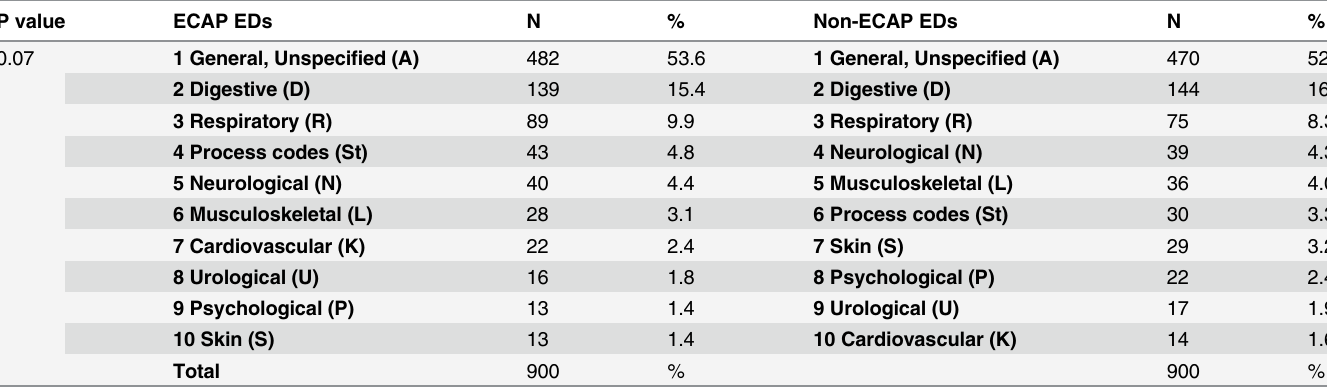
Table 3 shows the percentage of presented complaints in each ICPC domain comparing ECAP and non-ECAP EDs. The three most prevalent categories in the ICPC domains were equally represented, namely category A, General and Unspecified (53.6% versus 52.2%) D, Digestive. (15.4% versus 16.0%) and R, Respiratory (9.9% versus 8.3%).